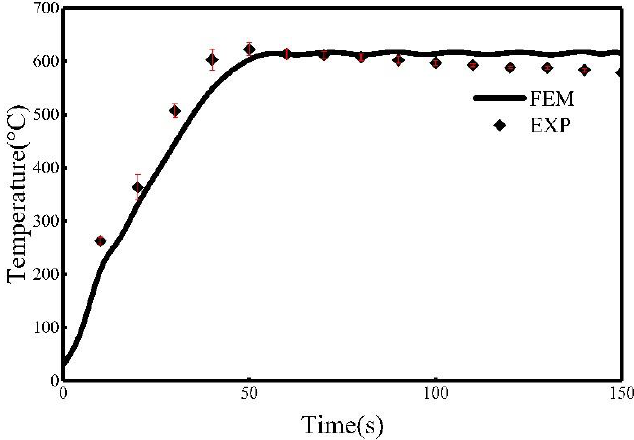
Figure 7. Comparison of temperature at the induction coil heating line S L 1 - S L 1 .